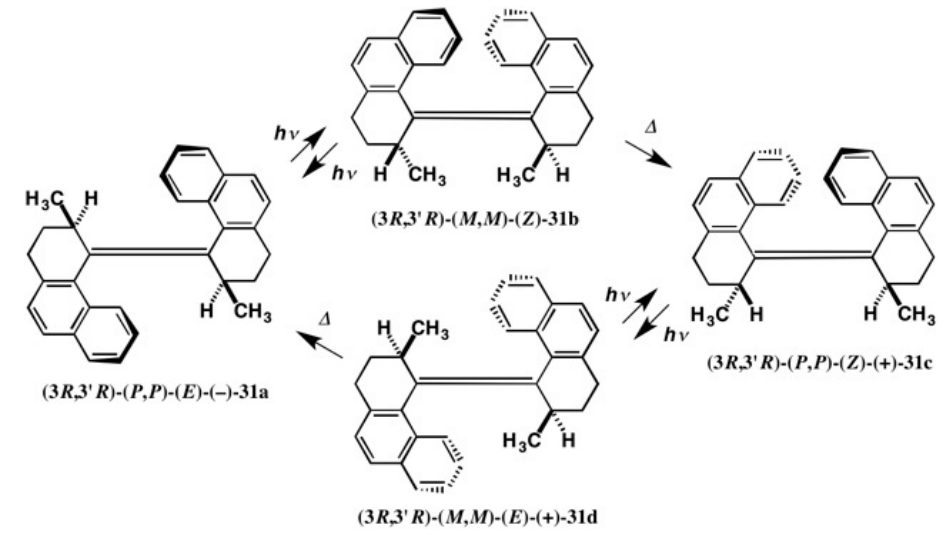
Figure 20. Light-powered molecular motor 31 and rotation mechanism, where 31a – 31d are rotation isomers. Redrawn with permission from [37].